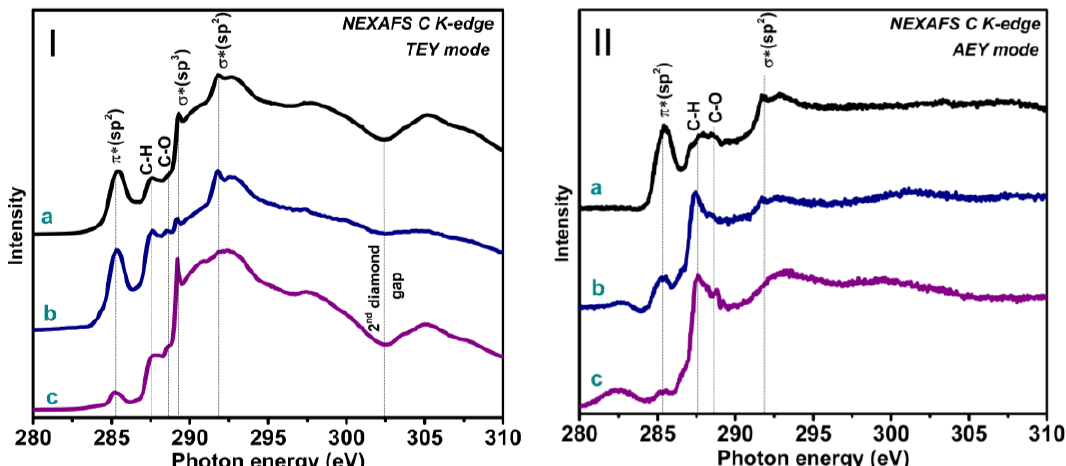
Figure 4. NEXAFS C K-edge spectra of Sample 1 ( a ), Sample 2 ( b ), and Sample3( c ) grown at different parameters of gas-jet synthesis. The spectra were measured in TEY ( I ) and AEY ( II ) modes.